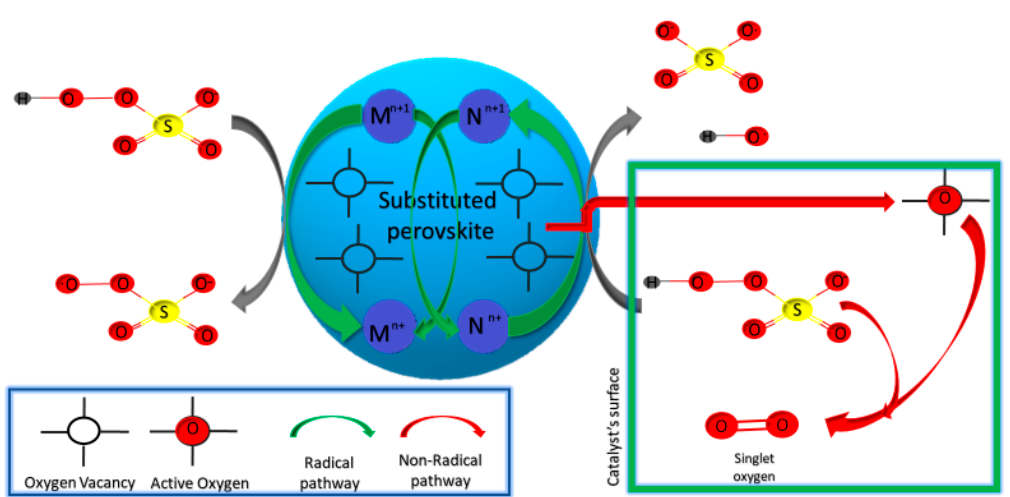
Figure 6. General mechanism of the substituted perovskites for the degradation of organic pollutants via two different (radical and non-radical) pathways.